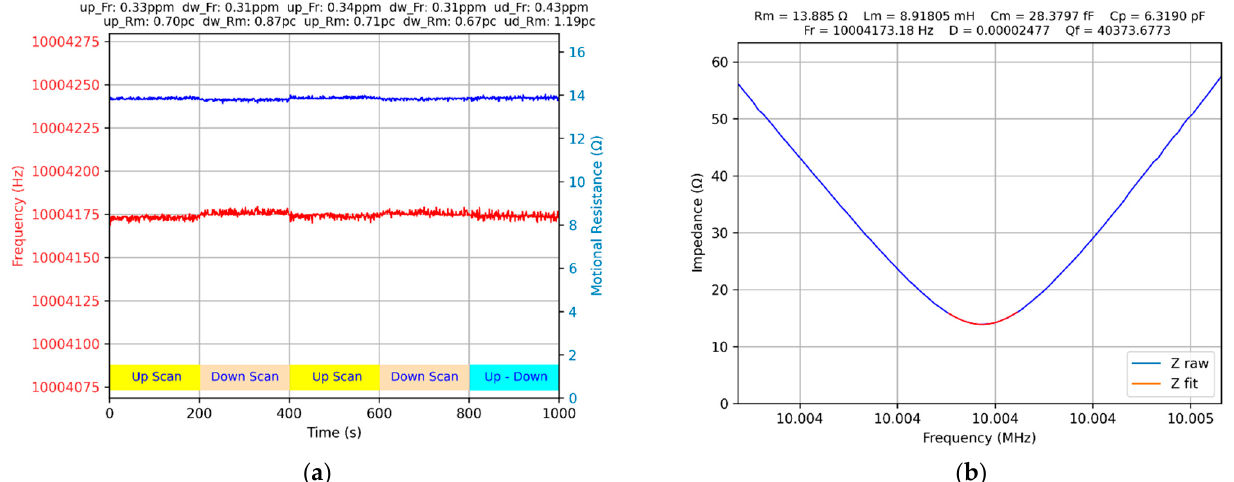
Figure 8. The measurement of the QCM in air with 10 Hz scanning step and 2 V sine wave ampli- tude: ( a ) scanning direction effect, ( b ) series resonant frequency tracking. ( a ) scanning direction effect, ( b ) series resonant frequency